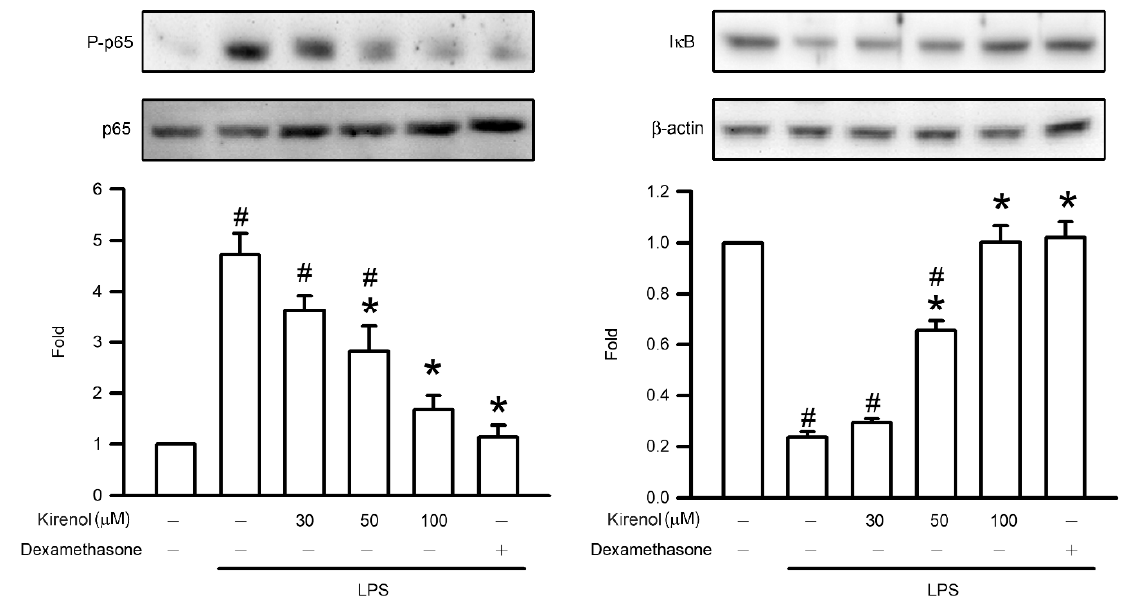
Figure 4. Kirenol protected against the phosphorylation of NF- κ B p65 and degradation of I κ B induced by LPS. The levels of NF- κ B p65 phosphorylation and I κ B degradation in the lung tissues were analyzed by Western blotting analysis. Values are shown the mean ± S.D. of 3–4 mice per group. # represents the significant difference compared with the Group I ( p < 0.05); * represents the significant difference compared with the Group II ( p < 0.05).